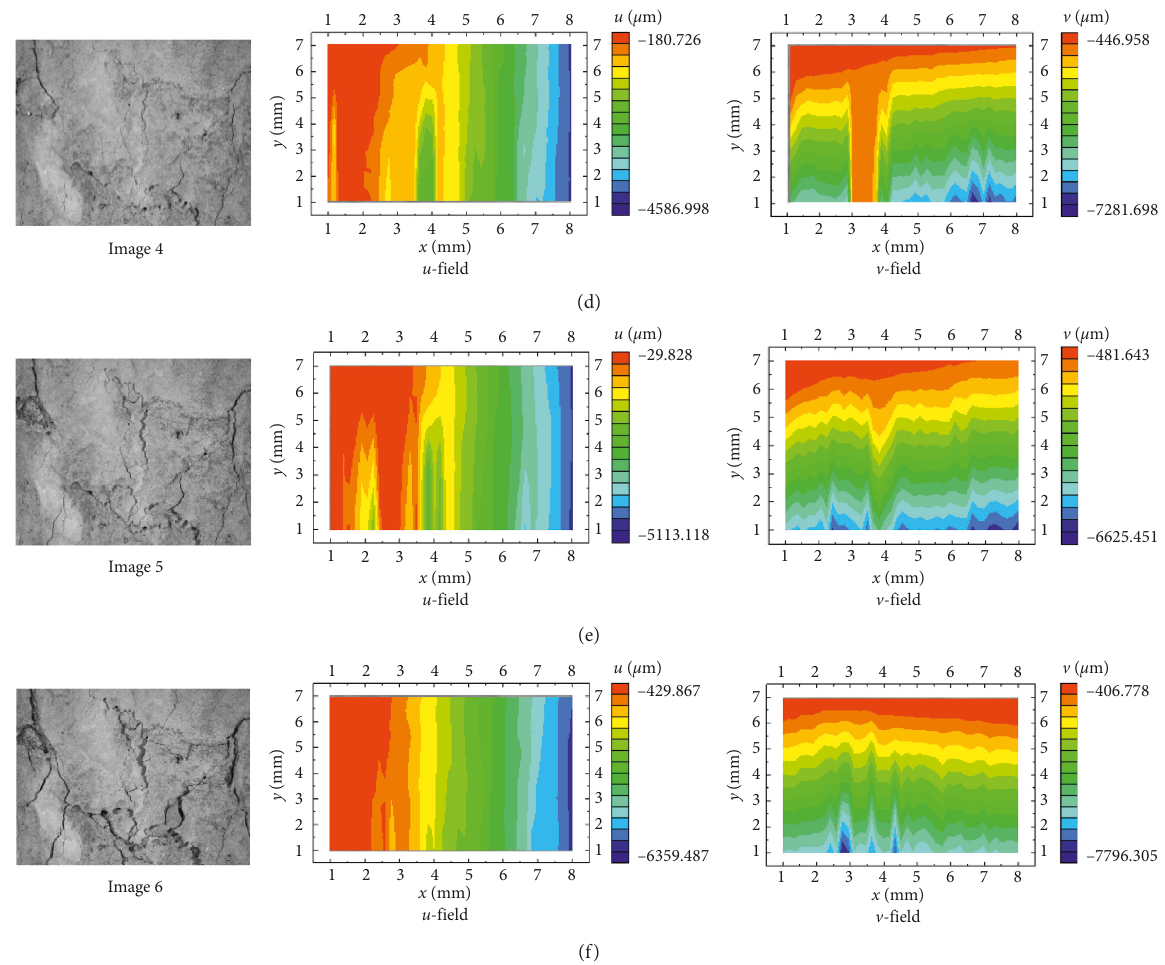
Figure 11: The field displacement ( u,v ) of the first crack area and surface topographies on the YPS-CC surface at the age of 28 days under (a) 5 MPa; (b) 10 MPa; (c) 15MPa; (d) 20MPa; (e) 25 MPa; and (f)